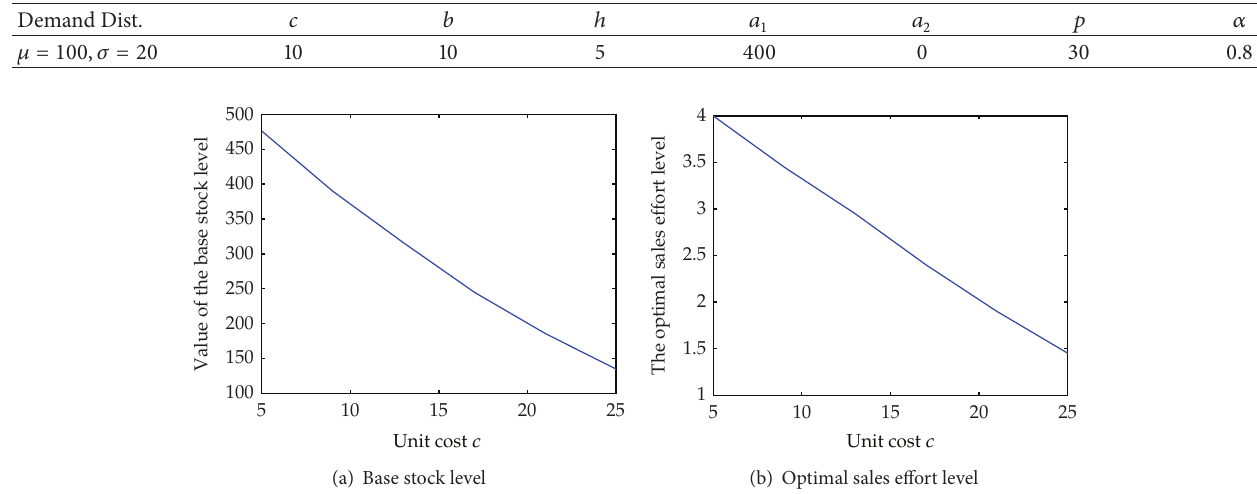
Table 1: Basic parameter settings.